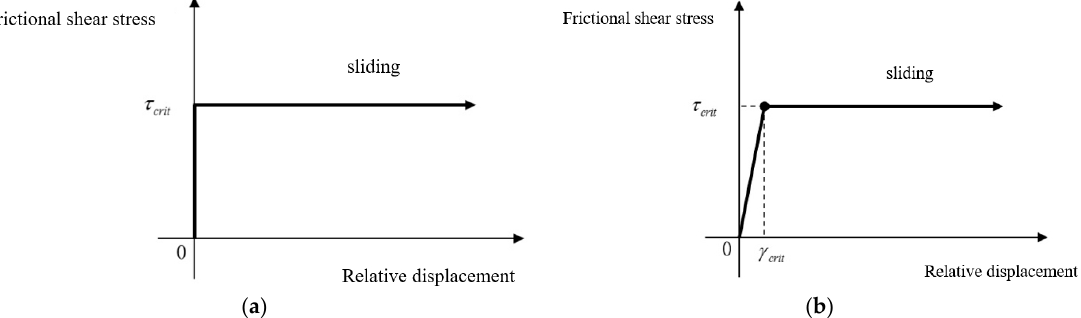
Figure 12. Relationship between relative displacement and friction shear stress of different contact methods: ( a ) Lagrange multiplier method, ( b ) penalty method ( τ crit is the critical friction shear stress, γ crit is the relative displacement of critical sliding.).